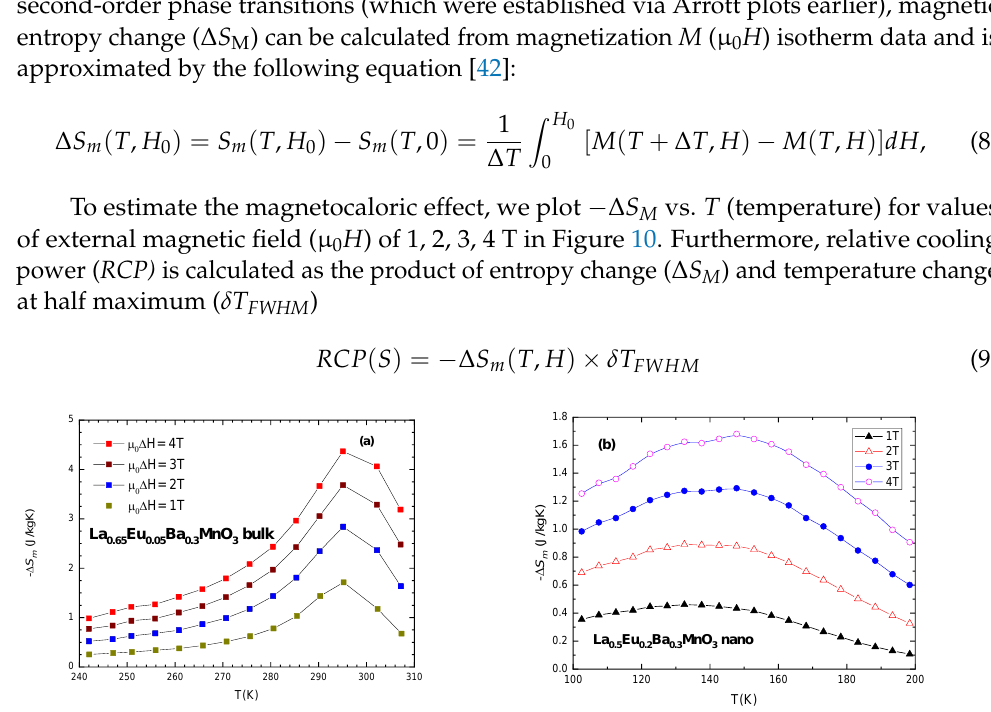
12 of 16 Figure 9. Calculated values for critical exponents for ( a ) the bulk sample with x = 0.05 ( b ) for the nanocrystalline sample with x = 0.05. Usually, the 3D Heisenberg model can describe the critical properties of the short- range interactions in doped manganites, together with other theoretical models, such as the mean field and tricritical mean field models. The critical exponent values are related to the range of exchange interaction J (r), spin, and system dimensionality. Within renor- malization group theory [37], J ( r ) = 1/r d+σ ( d — dimensionality of the system; σ — range of interaction). For σ greater than 2, the 3D Heisenberg model is valid. For σ < 3/2, the mean field theory of long-range interaction is valid. For an intermediate range, a different uni- versality class occurs. For the tricritical point, the critical exponents are universal: β = 0.25, γ = 1, and δ = 5. The tricritical point sets a boundary between two different ranges of order phase transitions. In this study, we focused on the general different magnetic properties of nano- and bulk polycrystalline manganites, not on their high-detail magnetic critical behavior. The modified Arrott plot (MAP) method is very accurate, and its agreement with the Kouvel – Fisher (KF) method and critical isotherm (CI) plots is usually quite re- markable [24,38]; indeed, some authors only analyze these data [39]. This is why we report here the results obtained by using MAP analysis. All of the samples exhibit a very small coercive field as evident from hysteresis curves, with the largest values of 170 Oe for x = 0.05 bulk and 960 Oe for x = 0.4 nano- sample. This can be largely attributed to low anisotropy and lack of pinning sites [40]. Nanoparticles show greater coercivity than their bulk counterparts, as shown in Tables 6 and 7. It has been found, in previous works, that nanoparticle coercivity tends to increase